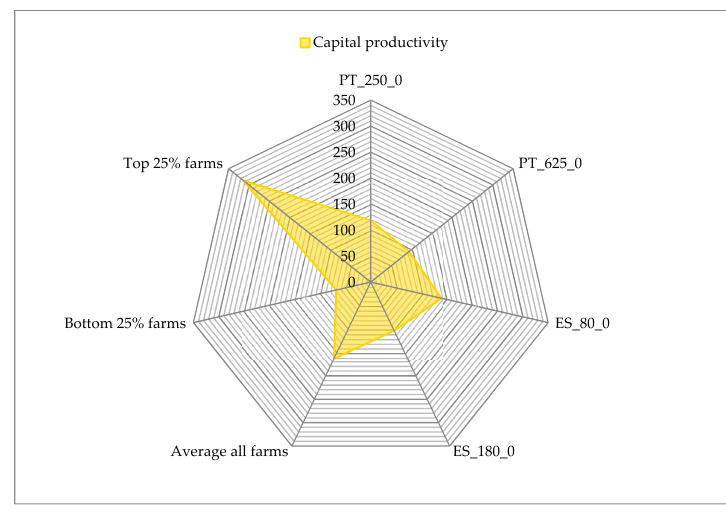
/ 1000 € ). Source: model Figure 18. – Capital (kg LW/1000 €). Source: model results. Figure 18. Capital (kg LW